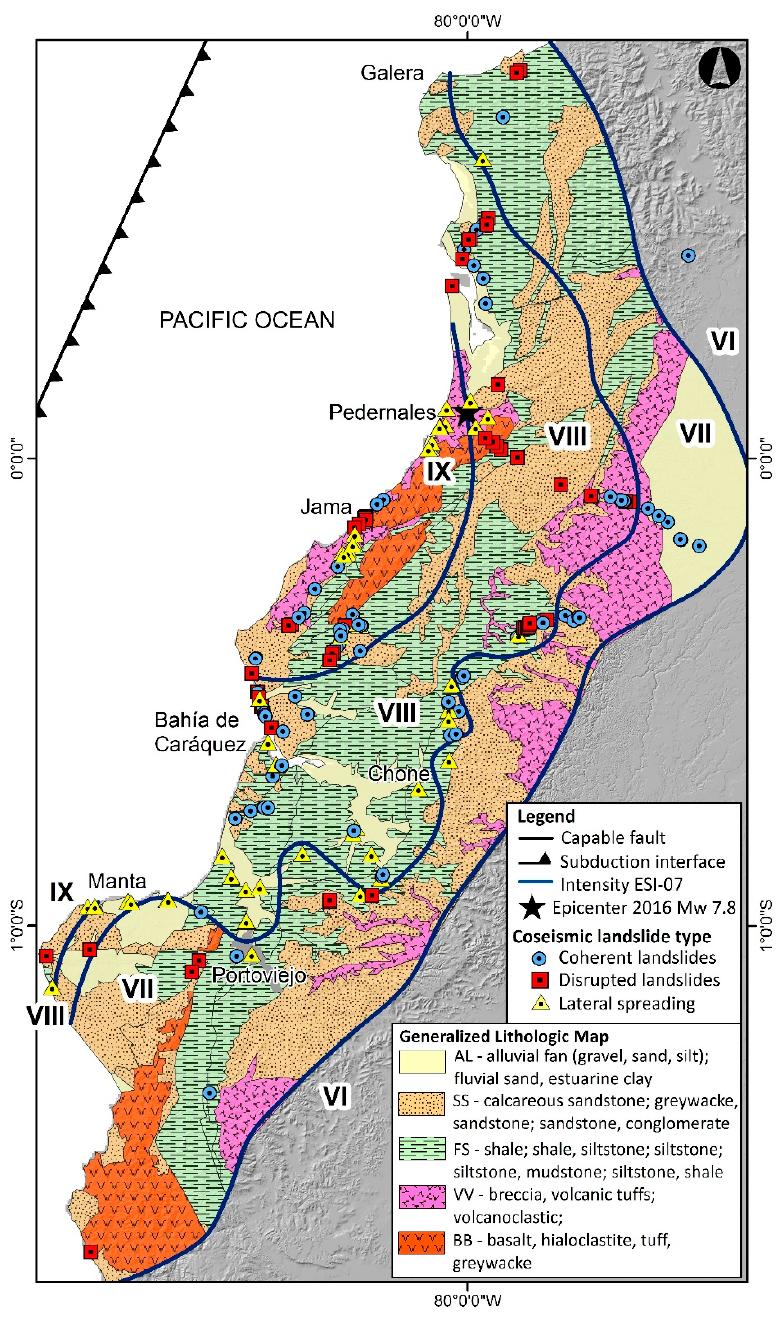
Figure 6. Simplified geologic map (modified from [55]) of the area comprised between isoseismals VII and IX ESI07 .